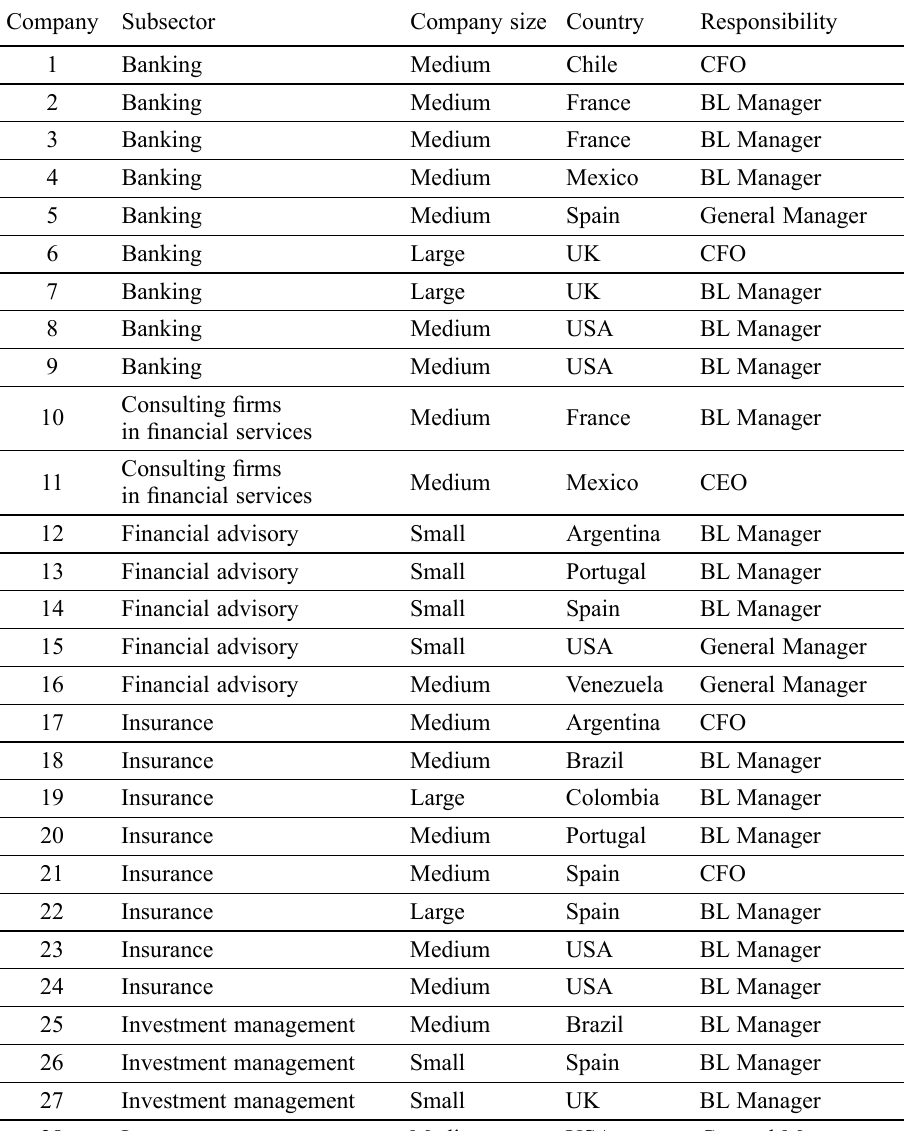
Table 1. Description of